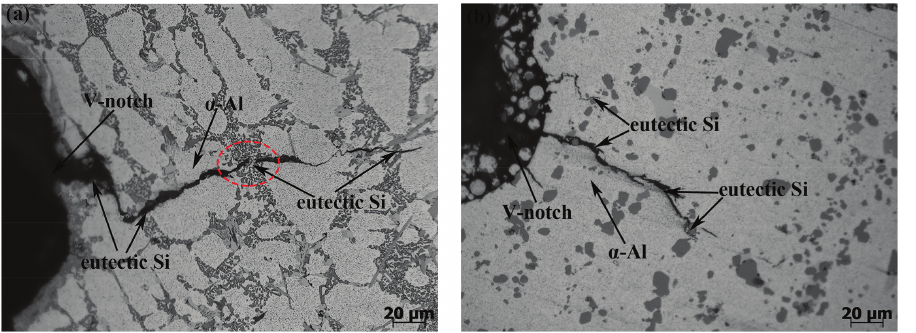
Figure 9: Fatigue crack propagate along the eutectic Si particles (a) as-cast alloy after 12,500 thermal cycles; (b) aging treated alloy after 12,500 thermal